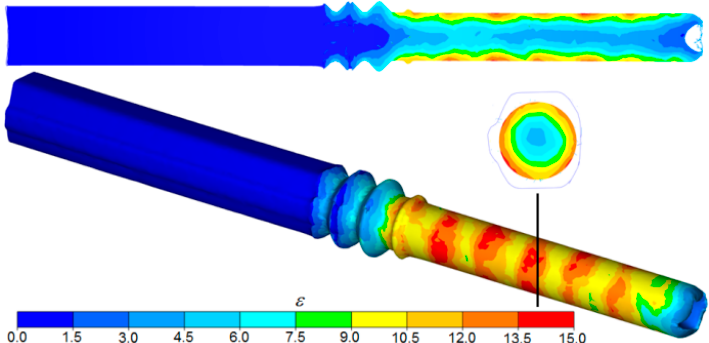
Figure 8. FEM strain distribution in a workpiece rolled in the helical pass of the skew rolling mill.